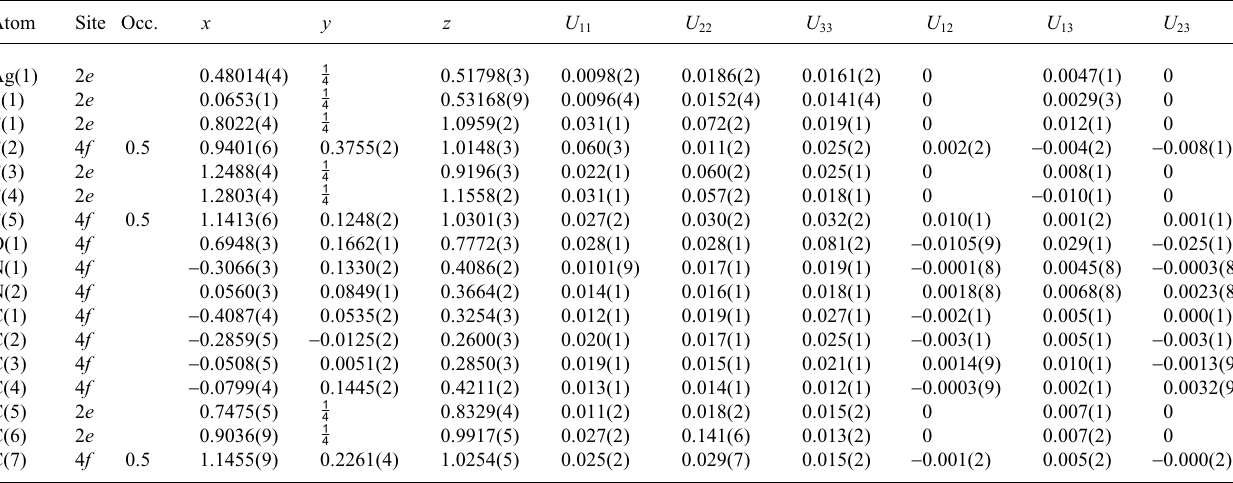
Table 3. Atomic coordinates and displacement parameters (in Å 2 )